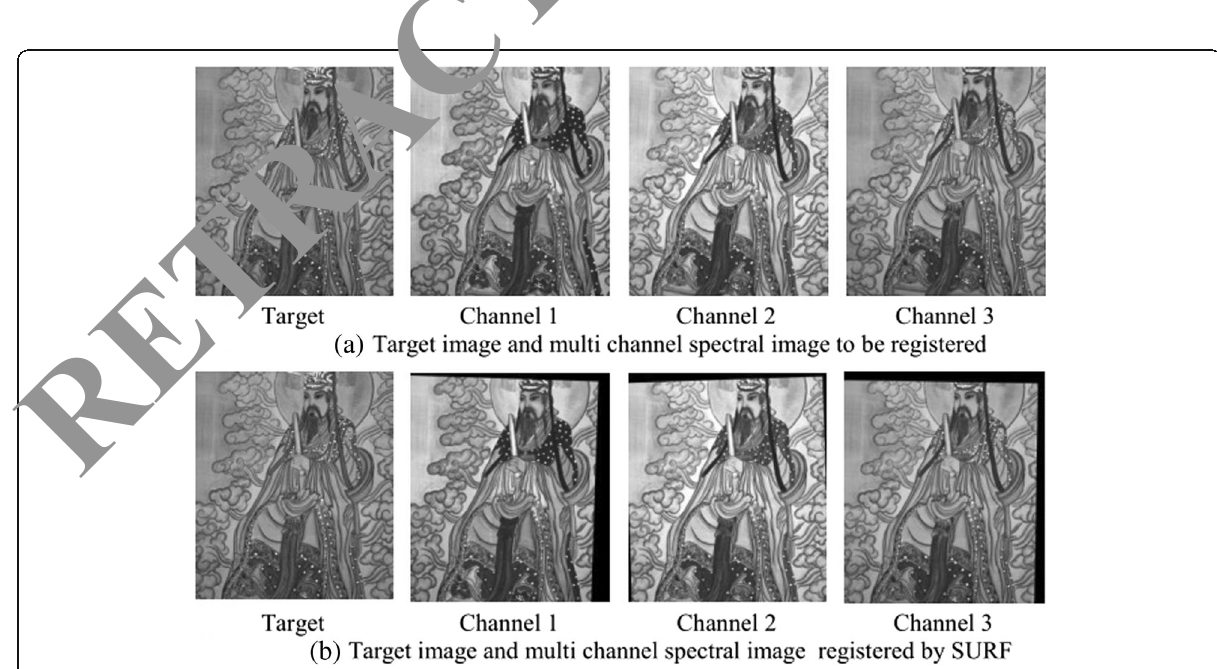
Fig. 2 Multichannel spectral original image and images registered by